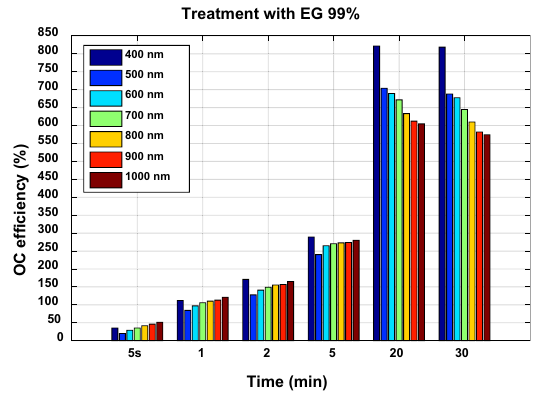
Fig. 6. OC e±ciency for the treatment with 99%